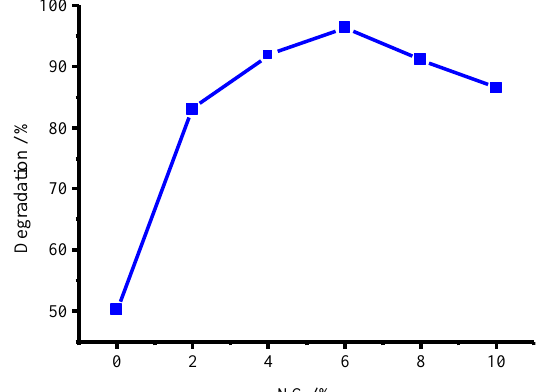
Figure 8. Dependence of photocatalytic activity for the as-prepared CuFe 2 O 4 /NG photocatalyst on NG percentage.